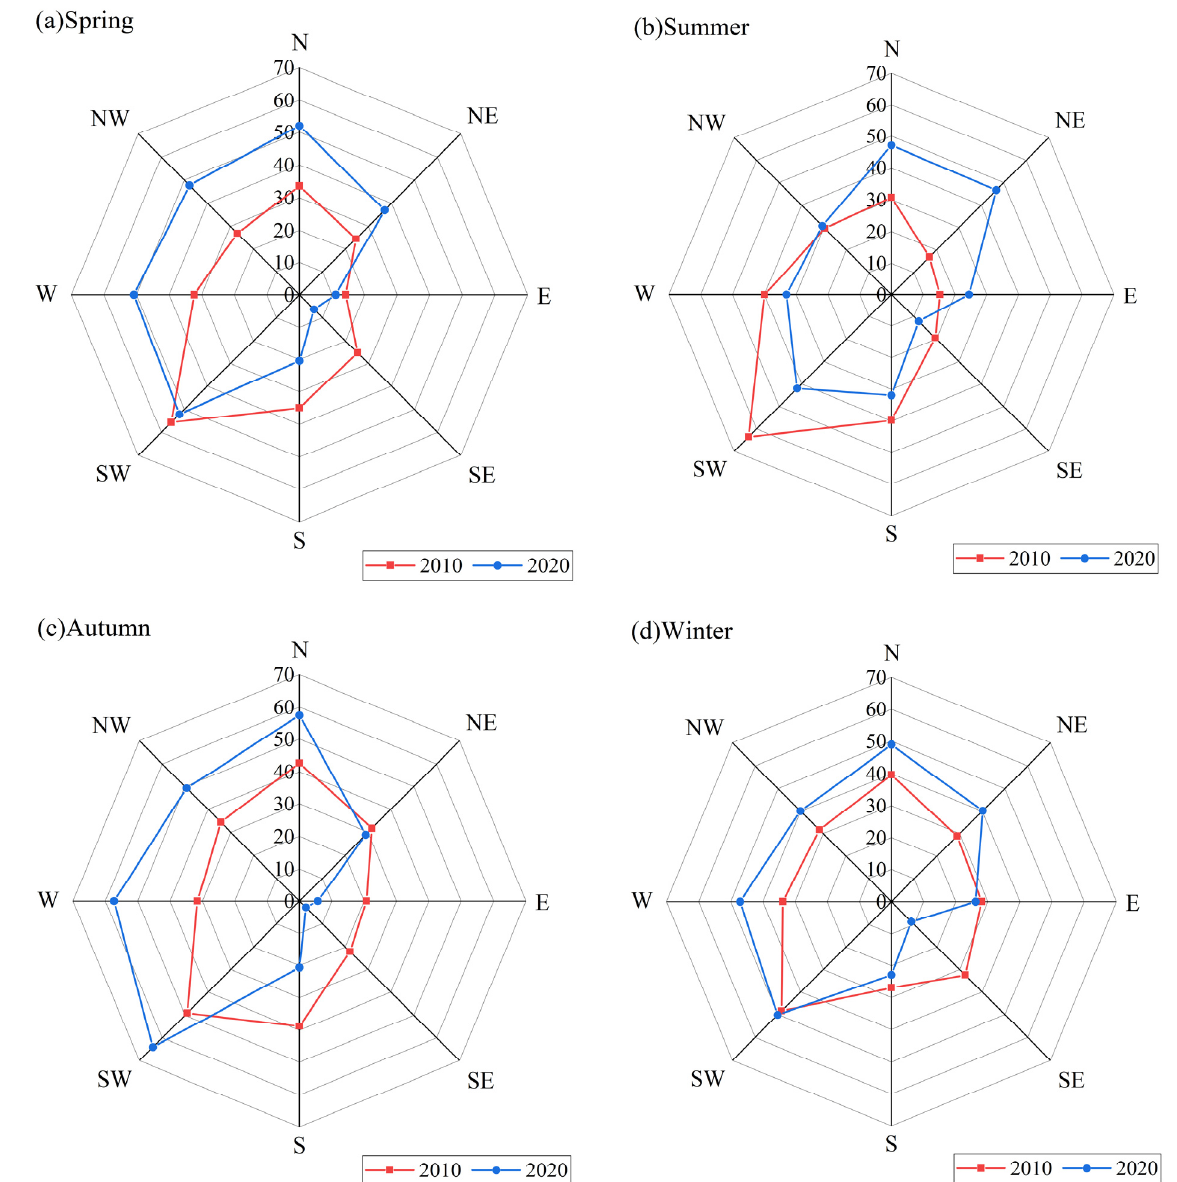
Figure 4. Results of the equal sector analysis of the thermal environment.